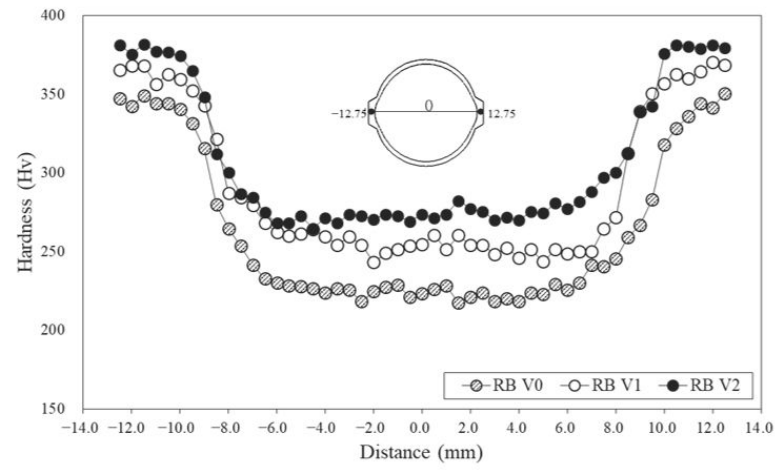
Figure 8. Hardness distribution of Tempcore rebars with various V